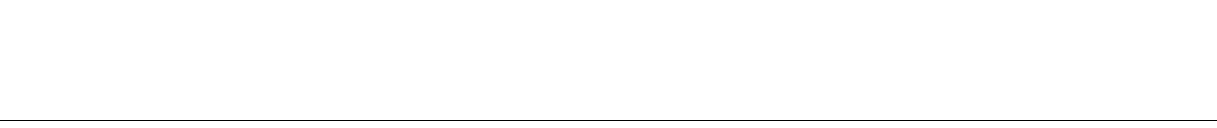
TABLE 4 | Minimum and maximum spatial dimensions consisting of 48 frequent patterns, Source: Author. Space Min Max Space Min Max Space Min Max Width of the ground fl